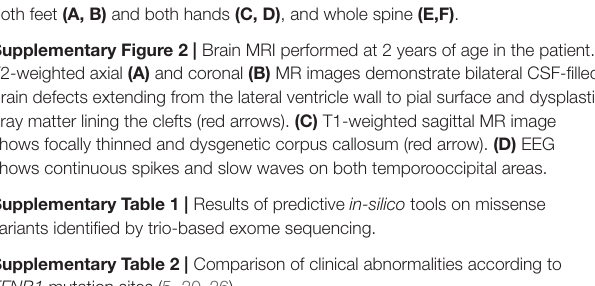
Supplementary Figure 2 | Brain MRI performed at 2 years of age in the patient. T2-weighted axial (A) and coronal (B) MR images demonstrate bilateral CSF-filled brain defects extending from the lateral ventricle wall to pial surface and dysplastic gray matter lining the clefts (red arrows). (C) T1-weighted sagittal MR image shows focally thinned and dysgenetic corpus callosum (red arrow). (D) EEG shows continuous spikes and slow waves on both temporooccipital areas. Supplementary Table 1 | Results of predictive in-silico tools on missense variants identified by trio-based exome sequencing. Supplementary Table 2 | Comparison of clinical abnormalities according to EFNB1 mutation sites (5,